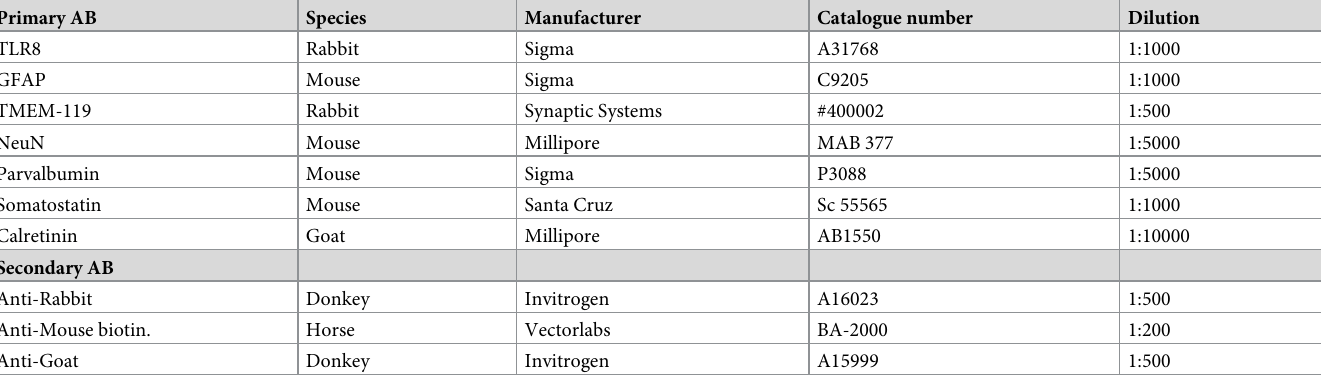
Table 1. Origin and concentrations of primary and secondary antibodies used in the study. Primary